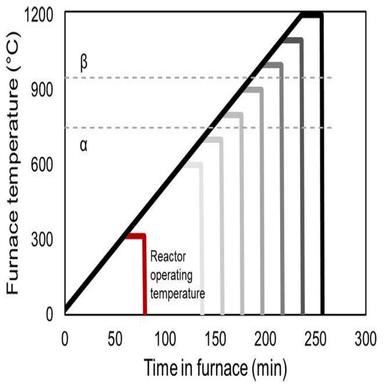
Furnace temperatures for each sample during heat treatments with the known Zr phase transitions indicated.